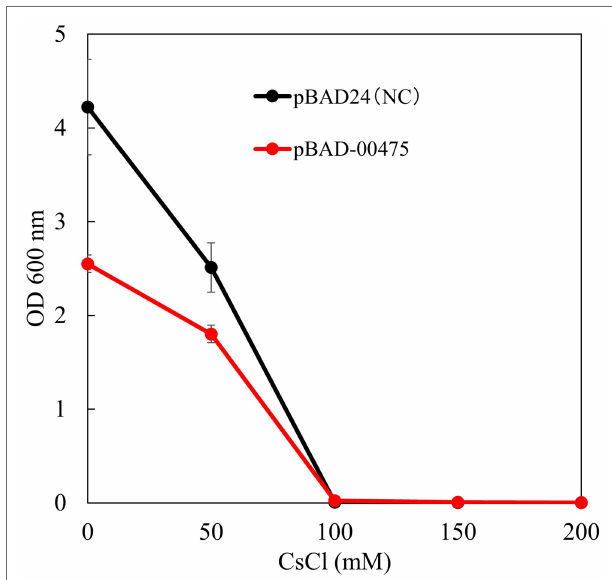
FIGURE 8 | Test to evaluate the Cs + resistance growth of strain KNabc/ pBAD-00475. The turbidity of each concentration of CsCl when strain KNabc/pBAD-00475 in LBK medium was cultured for 16 h. Error bars show the standard deviation of three independent experiments. As the negative control, KNabc/pBAD24 was